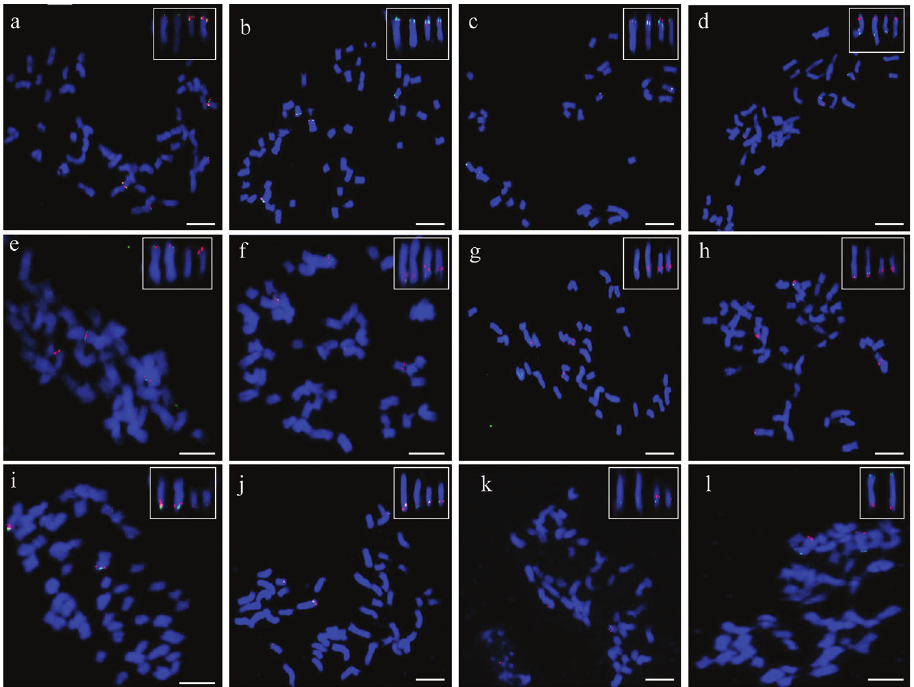
Figure 1. The order of two BACs on metaphase chromosome of G. hirsutum (AD ) TM-1 using Dual- 1 color-FISH. a 305A19(green)/348I20(red) b 305A19 (green)/64M24(red) c 144E04 (red)/64M24(green) d 64M24 (red)/400N03(green) e 305A19 (red)/378J07(green) f 118G12(red)/164I24(green) g 423C18 (red)/400L15(green) h 85P13 (green)/400L15(red) i 85P13 (red)/421E24(green) j 85P13 (red)/164I24(green) k D1 (red)/118G12(green) l 378J07 (green)/ A1 (red). Bar = 5 μm. moeologous chromosomes D 01 and A 01 were constructed (Fig. 2b, c). The order of h h individual BACs along the chromosome was generally collinear with the order of the corresponding SSR markers along the linkage map, except for a few closely linked loci, 144E04 (NAU2474) and 348I20 (NAU3253), 118G12 (NAU4891) and 400N03 (BNL2921), which displayed changes in the order between the genetic markers and BAC locations (Fig. 2a, b). Moreover, the BACs showed better concordance in the orders and positions between the two cytogenetic maps of the homoeologous chro- mosomes A 01 and D 01, except for 400N03 (BNL2921) (Fig. 2b, c), which sug- h h gests a rearrangement between the A 01 and D 01 homoeologous chromosomes in h h the process of evolution. A significant difference between the two types of maps was viewed, that is, the markers flanking the middle region were separated by short genetic distance but long physical distance. For example, the genetic distance between mark- ers NAU3433 and BNL2921 is 11.2% of total genetic distance of chromosome 15 (D 01), but the physical distances between these two markers is 59.4% of the total h length of the chromosome D 01 (Fig. 2a, h